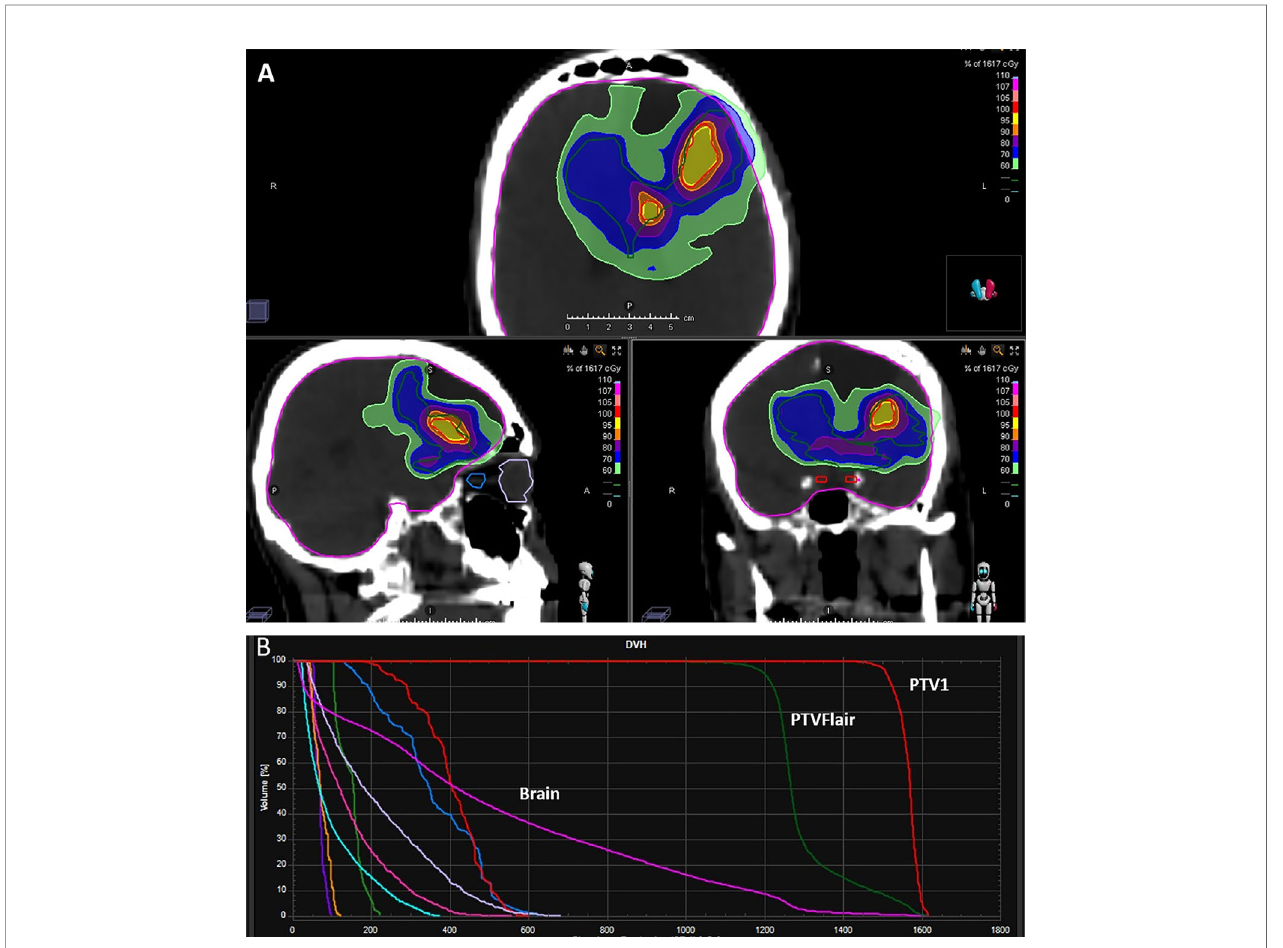
FIGURE 1 | Examples of (A) dose distribution and (B) typical dose volume histogram (DVH) for a prescription dose of 15 Gy in 3 fractions to PTV1 and 12 Gy in 3 fractions to PTV